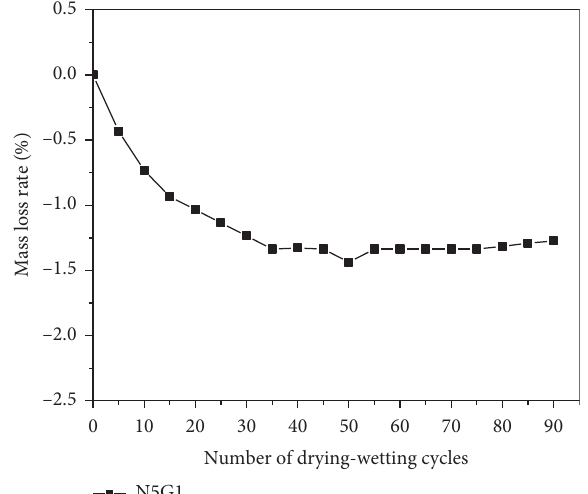
Figure 4: Variation of the mass loss rate of concrete under 5% Na 2 SO 4